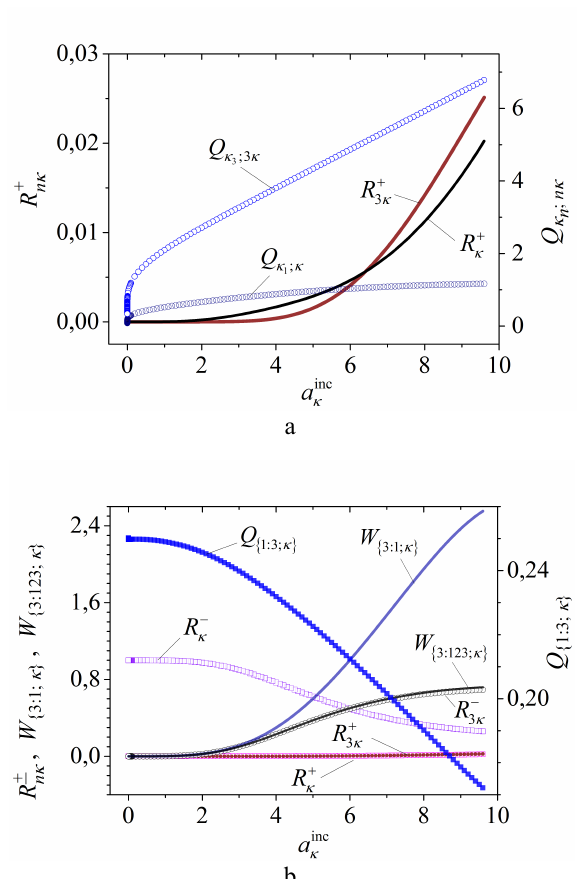
Figure 6: Curves at the excitation frequencies of the induced nonlinear layer: (a) the energetic characteristics and the Q-factors for